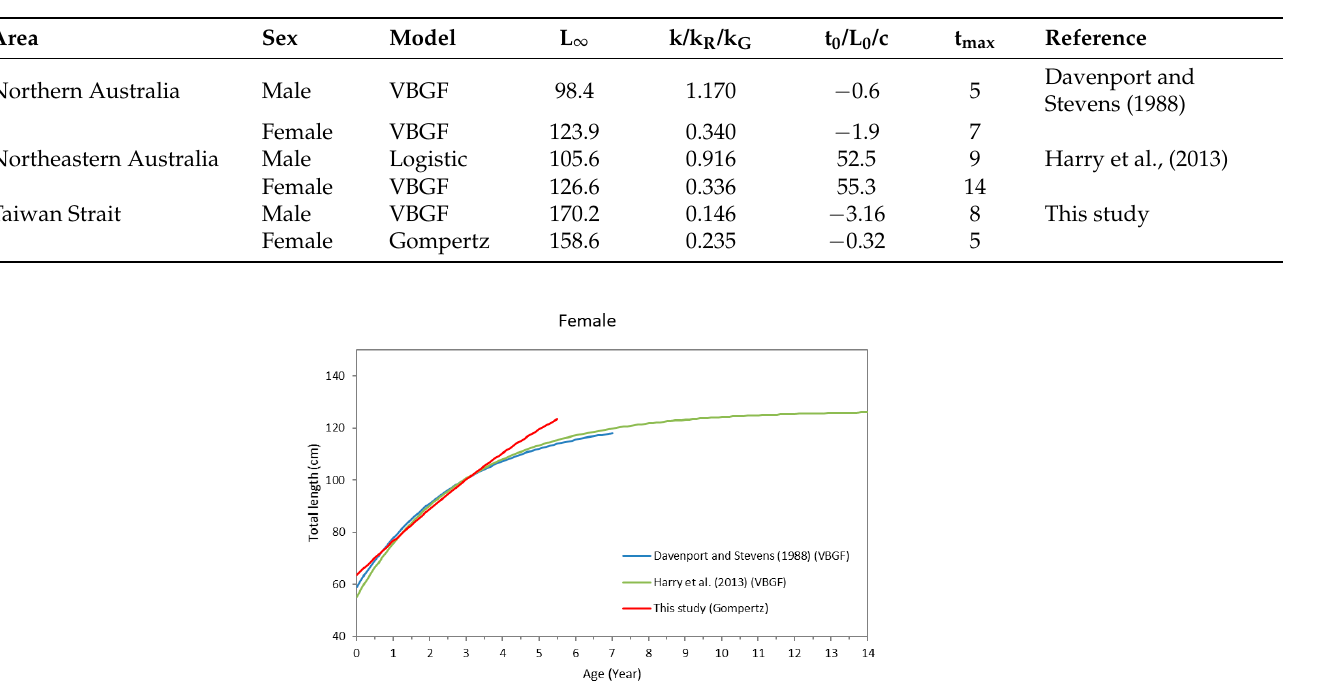
Table 3. Comparison of growth parameters of spot-tail sharks estimated from different studies.